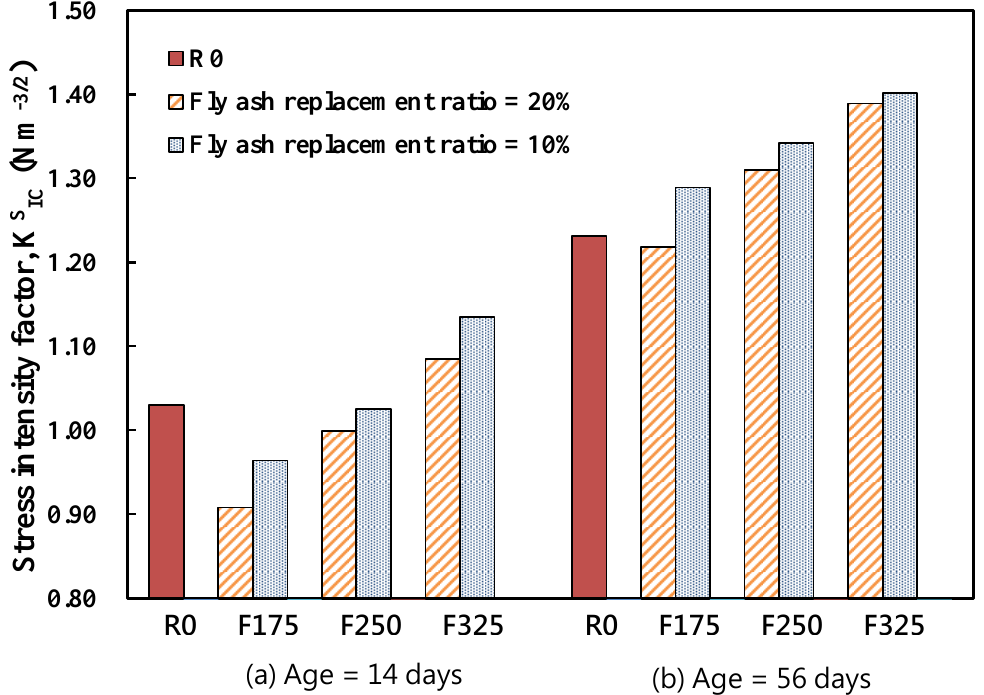
Figure 7. Stress intensity factor of concrete with various fineness levels, and the replacement ratio of fly ash.